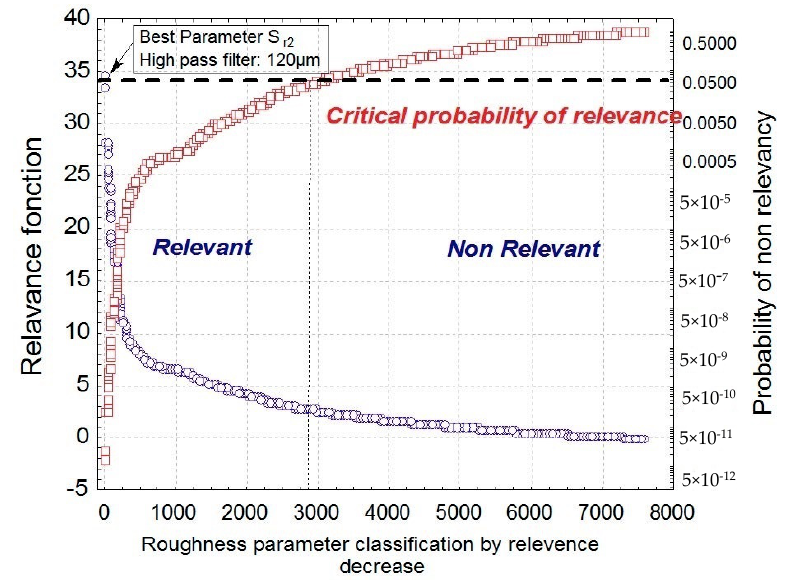
Figure 6. Plot of the relevance function F applied on the global model and their associated critical values (i.e., the probability of affirm fallacy that a relation exists although there is no relation) versus the position of relevance in descending order.